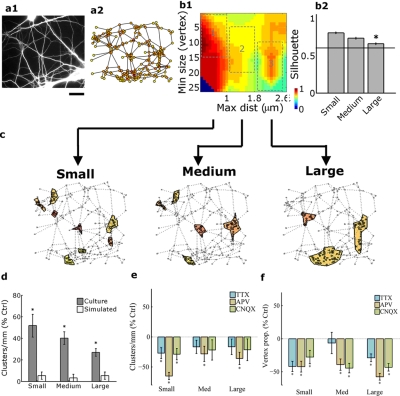
DCCs formation is non-random and is enhanced by synaptic activity.(a1) an example of a dendritic network (anti-MAP2 antibody staining) from which a DC connectivity graph was abstracted (a2). (b1) Clustering analysis of the graph based on maximal distance among the vertices and minimal size of the cluster. The colors represent the values of a Silhouette metric test. To facilitate further analysis, DCCs were grouped into three classes (small, medium and large, respectively reflected as 1,2 and 3 in b1, b2 and c1–c3). Only clusters bearing silhouette values above 0.6 were further considered for analysis. (d) The number of DCCs (normalized by total dendritic edge length in each field) is higher when compared to simulations of random contact-superposition (see methods and text for details) (p<0.01 by the Wilcoxon sing test, performed for each class separately; n = 33 and 10 fields for culture and simulation, respectively). (e) Synaptic inhibition has an overall decrimental effect on the normalized number of DCCs (p<0.05 for the medium cluster class by the Kruskal-Wallis test; n = 33 culture fields for control values and 11 fields for each treatment). When compared separately for each DCC class, all treatments lead to a decrease in the number of DCCs (p<0.001 by the Wilcoxon sign test). (f) Similarly, the proportion of the vertices involved in DCCs was decreased by synaptic activity inhibitors (p<0.05 for the medium and large cluster classes by the Kruskal-Wallis test; n = 33 culture fields for control values and 11 fields for each treatment). Here again, when compared separately, the proportion decreased in all but the small TTX-treated class (p<0.001 by the Wilcoxon sign test, same sample sizes). Scale bar: 12 µm.